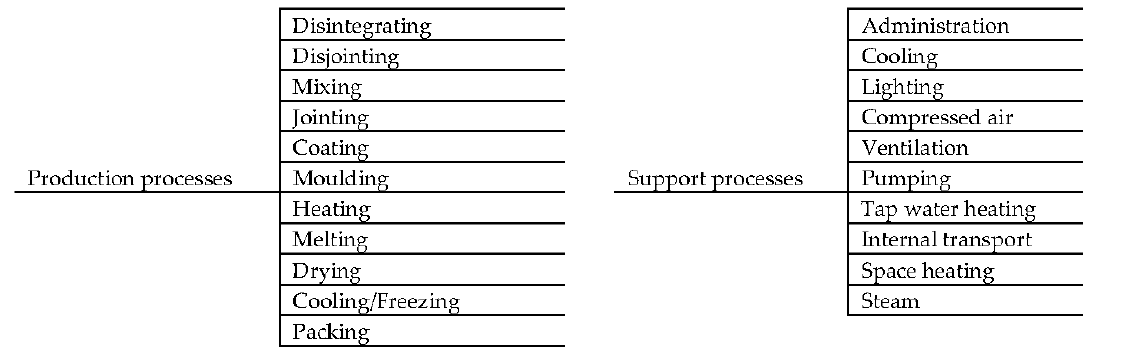
Figure 1. Taxonomy for energy unit processes in the manufacturing industry according to Rosenqvist et al. [20].